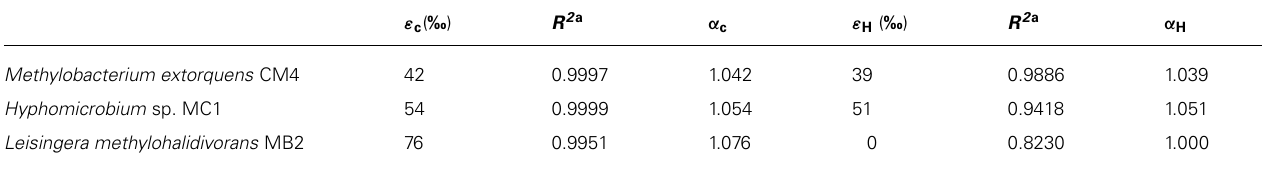
Table 3 | Isotopic enrichment ( ε ) and fractionation ( α ) factors for carbon and hydrogen during growth with chloromethane.